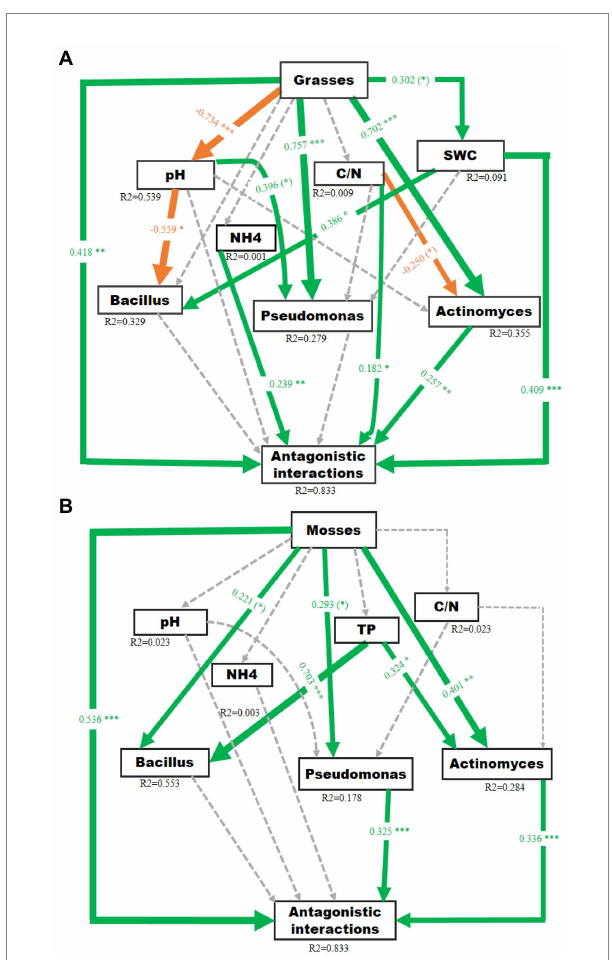
FIGURE 4 Structural equation models reflecting the direct and indirect (through changes in soil pH, carbon/nitrogen ratio, total phosphorus, soil water content and bacterial abundance) effects of Antarctic dominant plants on antagonistic potential in the soil of (A) Grasses P (Chi-square) = 0.50, P (RMSEA) = 0.57, (GFI) = 0.97 and (B) Mosses P (Chi-square) = 0.12, P (RMSEA) = 0.18, (GFI) = 0.90. Square boxes display variables included in the model: Exogenous variable (plant’s functional group affiliation) is given on top, endogenous variables below. Green and orange solid arrows indicate significant positive and negative effects, respectively. Dashed arrows indicate non- significant effects. Arrow width corresponds directly to the standardized path coefficient. R2 values associated with response variables indicate the proportion of explained variation by relationships with other variables. Values associated with arrows represent standardized path co-efficient. (*): p < 0.1, * p < 0.05, ** p < 0.01, *** p <